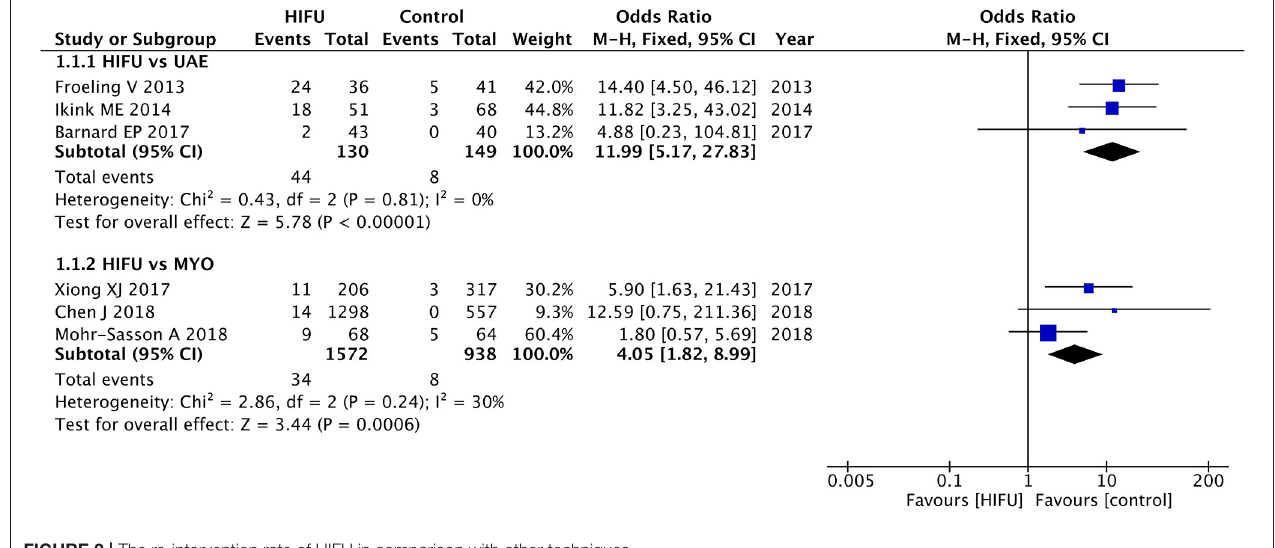
FIGURE 2 | The re-intervention rate of HIFU in comparison with other techniques.